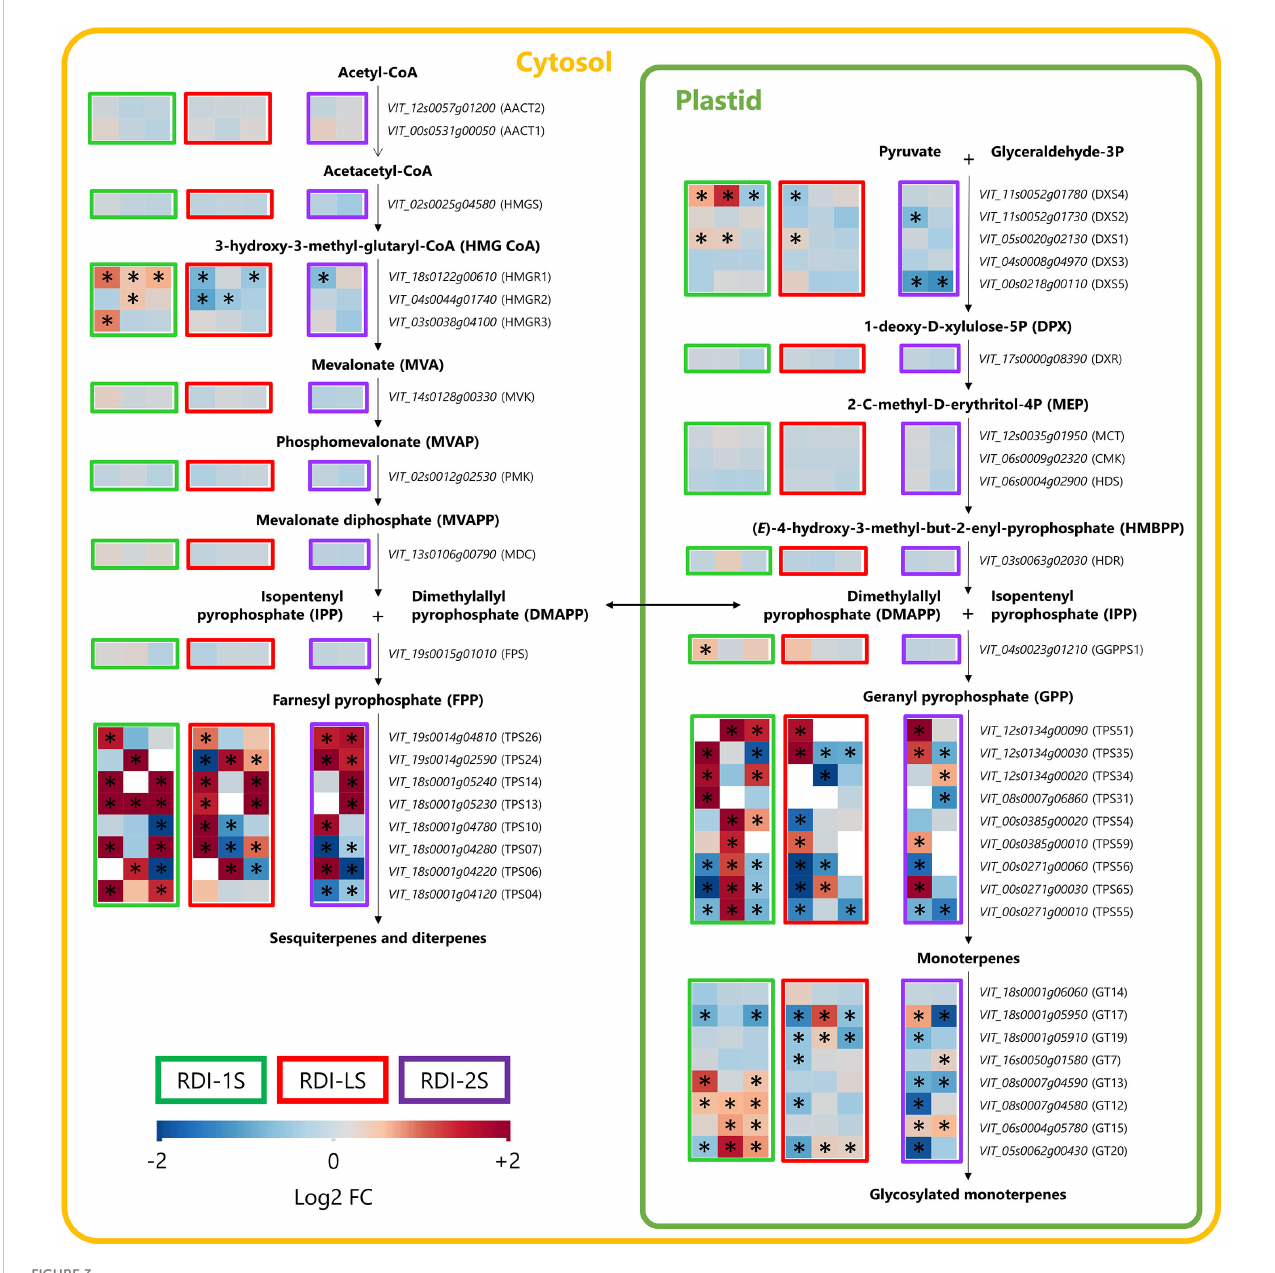
FIGURE 3 Modulation of MVA and MEP terpenes pathways in berries of Sangiovese grapevines ( Vitis vinifera L.) subjected to different irrigation regimes: RDI-1S, severe water de fi cit applied from berry pea size to beginning of veraison (green block); RDI-LS, water de fi cit applied during lag phase (red block); RDI-2S, severe water de fi cit applied from beginning of veraison to harvest (purple block). Log2FC (RDI/FI) levels of differential gene expression are presented at the beginning of veraison (left box), mid-ripening (central box), and harvest (right box). White empty boxes indicate not detected genes. Asterisks indicate signi fi cant differences (p < 0.05) between